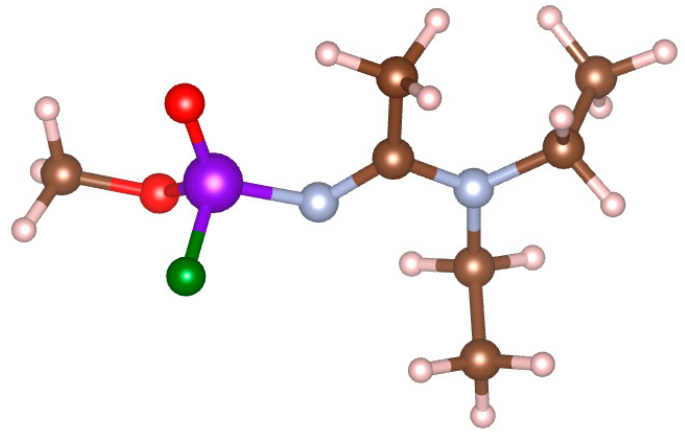
Figure 1. The molecular structure of the A232 nerve agent. Atom color scheme: C, brown; H, pink; N, blue; O, red; P, violet; F, green.